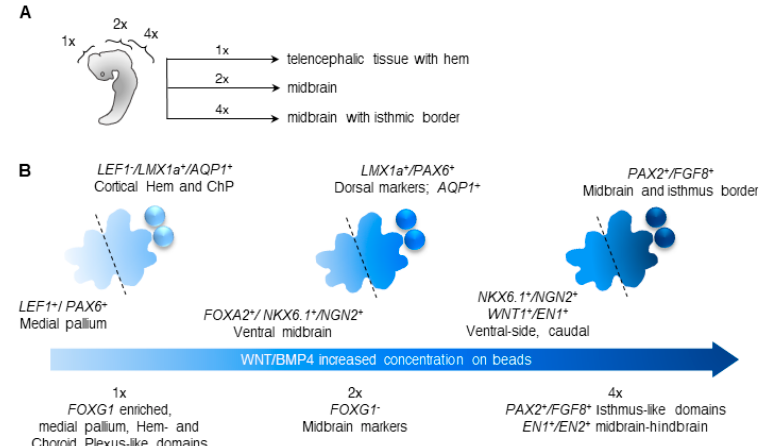
Figure 6. WNT/BMP4 gradients regulate the AP and the DV patterning of human brain organoids. ( A ) Schematic of an embryo, showing the different concentrations of CHIR and BMP4 which were used in the above-described experiments. The 1× condition represents a telencephalon-enriched organoid with cortical hem and ChP characteristic markers. The 2× condition generates dorsal and ventral midbrain-related fates. The 4× condition is characterized by midbrain fates with isthmic border markers. ( B ) Summary of the achieved polarization of human brain organoids. Increasing concentrations of CHIR and BMP4 has generated organoids with elevated forebrain, hem and ChP markers; dorsal and ventral midbrain genes; and isthmic (MHB border) domains. Each organoid was polarized, and contained a dorsal area (in close proximity to the beads) and ventral area (at the far side). In neurodevelopmental diseases such as autism spectrum disorder and schizophrenia part of the pathophysiology is attributed to altered regional specification and defective connectivity. Therefore, achieving reproducible topographic organization in human organoids and generating multi-regional domains in a single system are currently an emerging field. Our protocol provides an opportunity to pattern the developing tissues in a more refined manner and to perform live-imaging. In future studies, it will be important to examine the extent to which the polarity can be maintained during long-term growth.